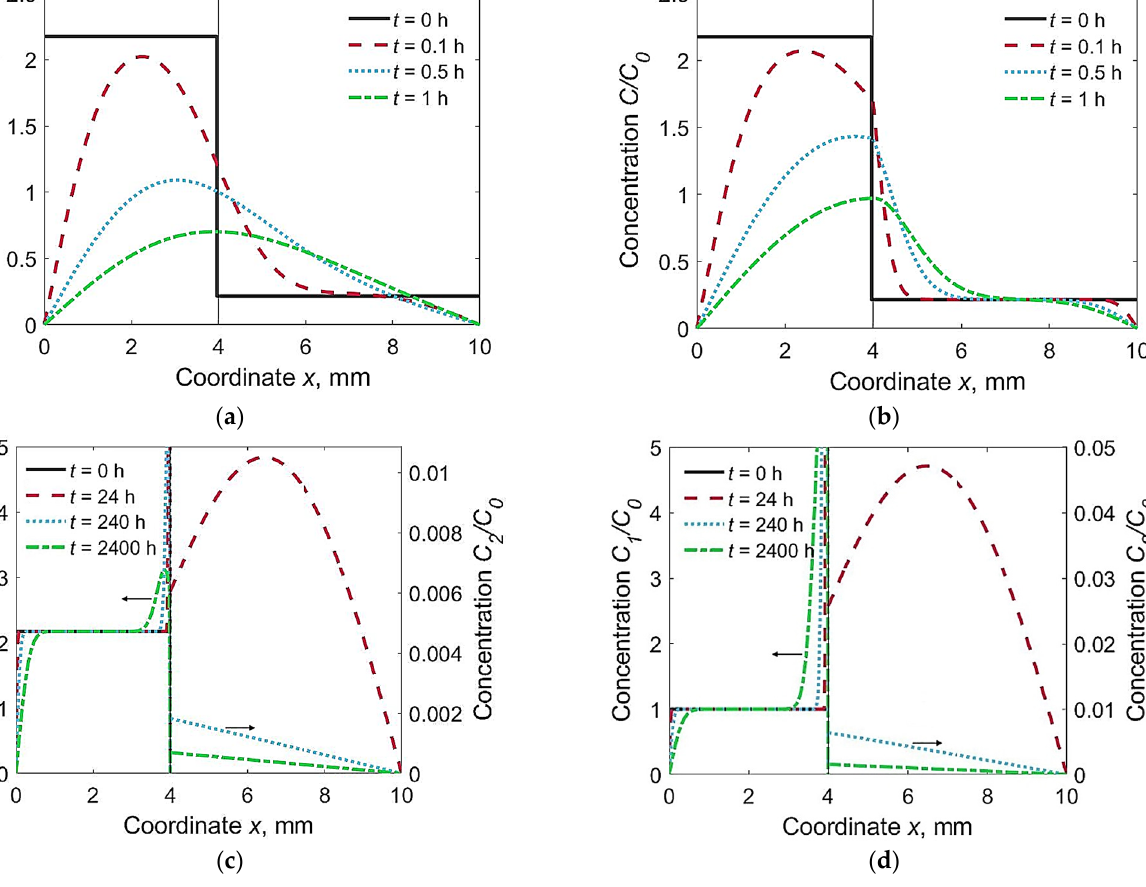
Figure 2. Distribution of relative hydrogen concentration in welded joints at different time t : ( a ) F + F , C 02 / C 01 = 0.1; ( b ) F + M , C 02 / C 01 = 0.1; ( c ) A + M , C 02 / C 01 = 0.1; ( d ) A + M , C 02 / C 01 = 1.